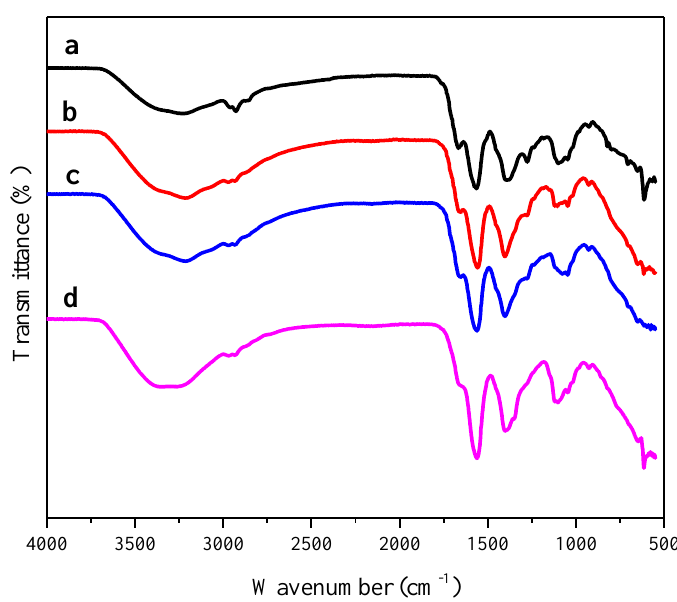
Figure 6. FTIR spectrum of the bio-crude oils derived from TPW, representing 250-30-A ( a ), 250-45-A ( b ), 250-60-A ( c ), and 250-30-B ( d ).